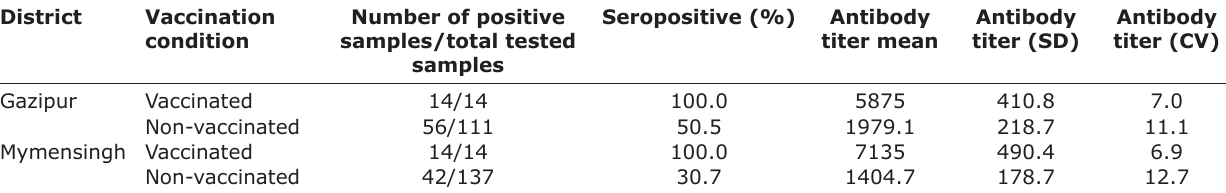
Table-2: Serological detection of ARV according to the vaccination of chickens. District